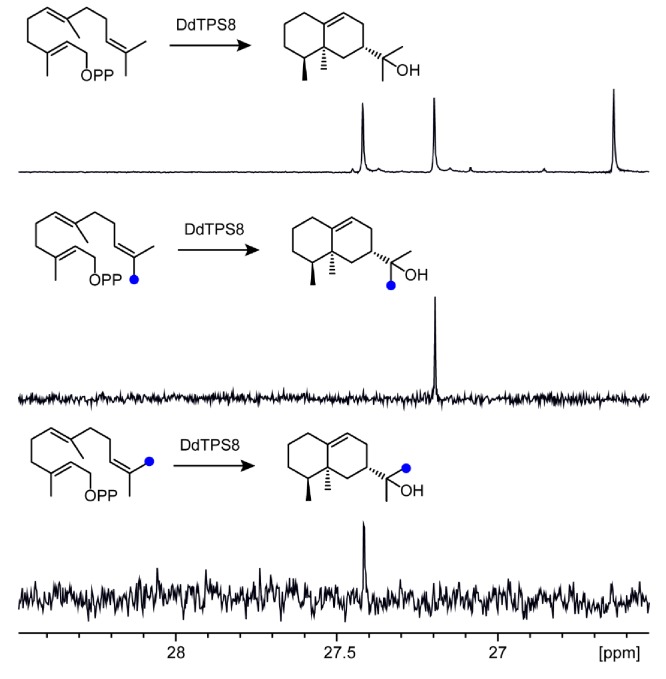
Incubation experiments with (12–13C)FDP and (13–13C)FDP and DdTPS8.